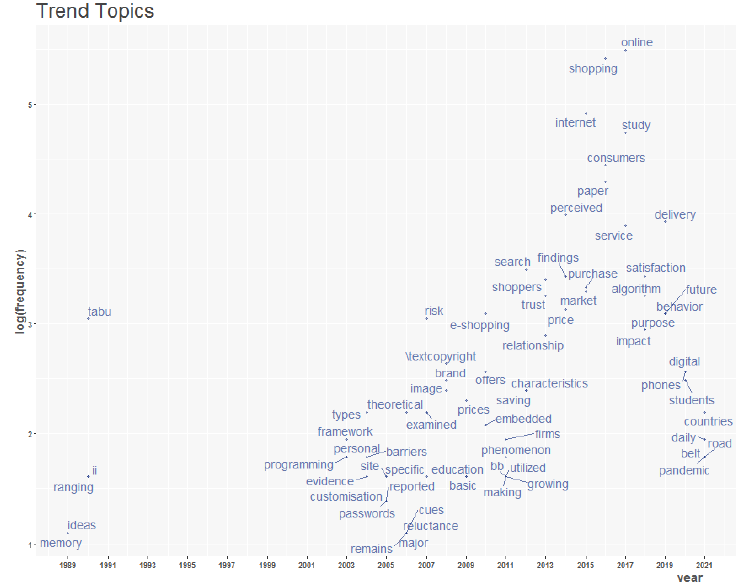
Fig. 9. Trend Topic terms on ISOP